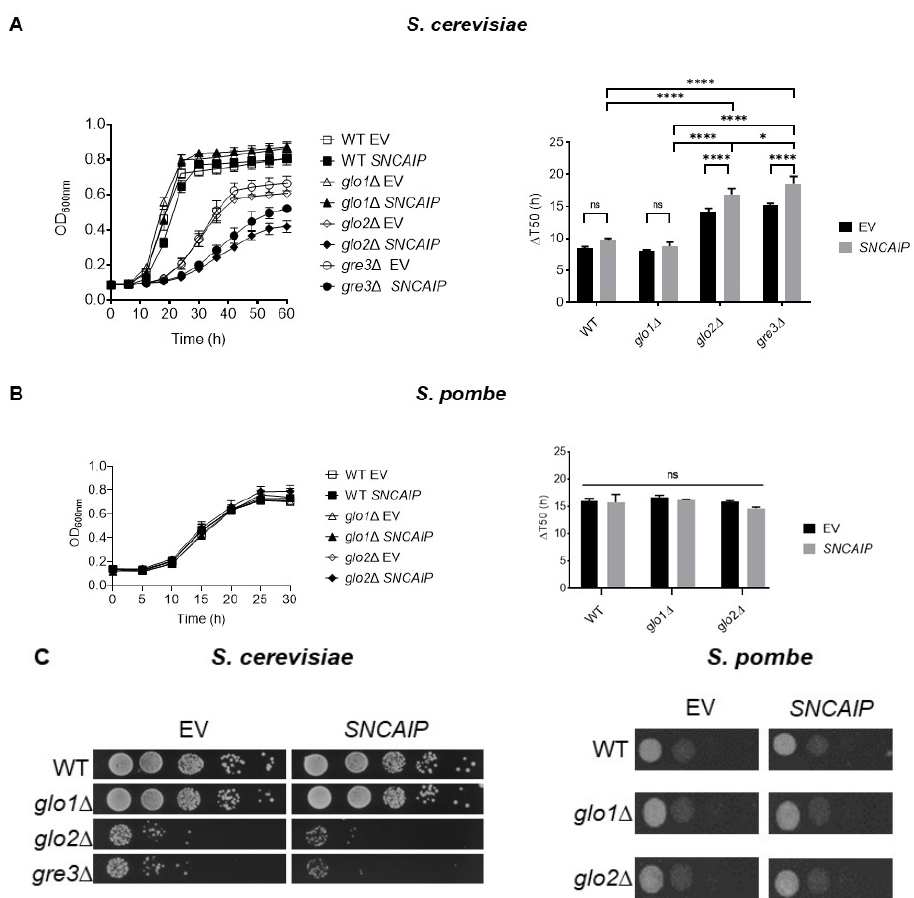
Figure 2. Analysis of the repercussions of a disrupted methylglyoxalase system and aldose reductase activity on the growth of SNCAIP ‐ expressing S. cerevisiae ( A and C left) and S. pombe ( B and C right). ∆ T 50 indicates the number of hours needed for a strain to reach the OD value corresponding to half the OD max value. Data represent the combined results of three clones per strain. Error bars represent the standard deviations based on the obtained data of these clones. Significance is determined using a one ‐ way ANOVA test ( p ‐ value of 0.05, significance indicated by the asterisk; n = 3, * = p < 0.05, **** = p < 0.0001). Non ‐ indicated differences between strains are not significant. Growth of S. cerevisiae and S. pombe was measured using 96 ‐ well and 24 ‐ well plates, respectively. EV = empty vector; ns = not significant.